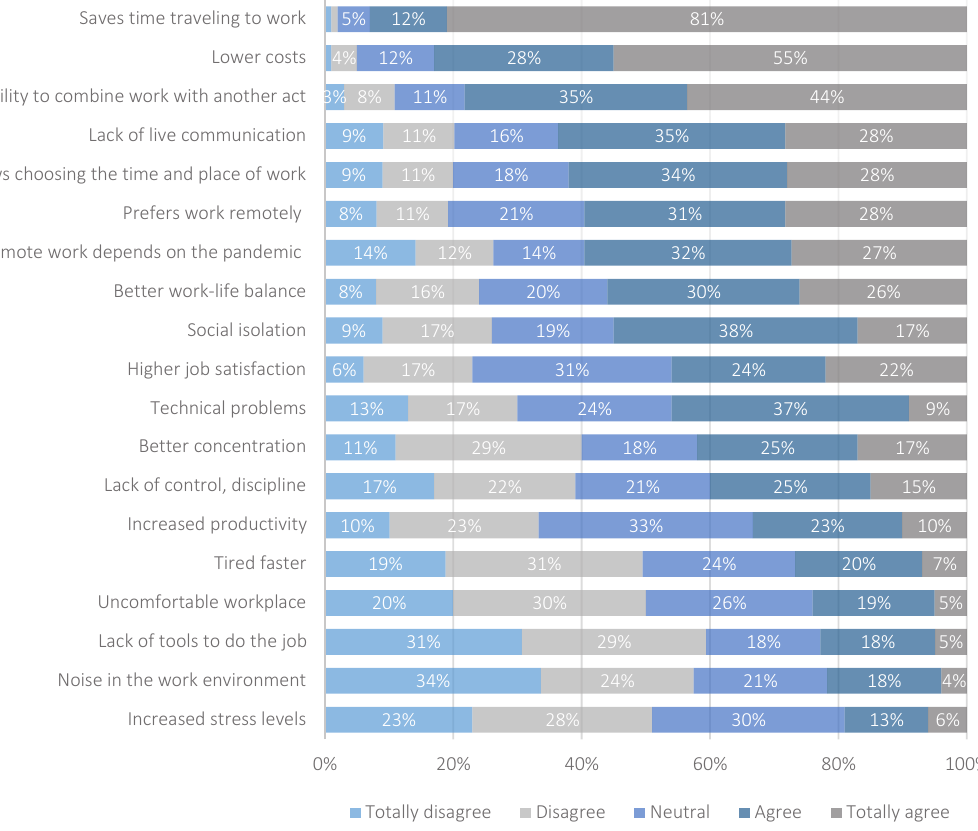
Figure 2. Assessing aspects of remote